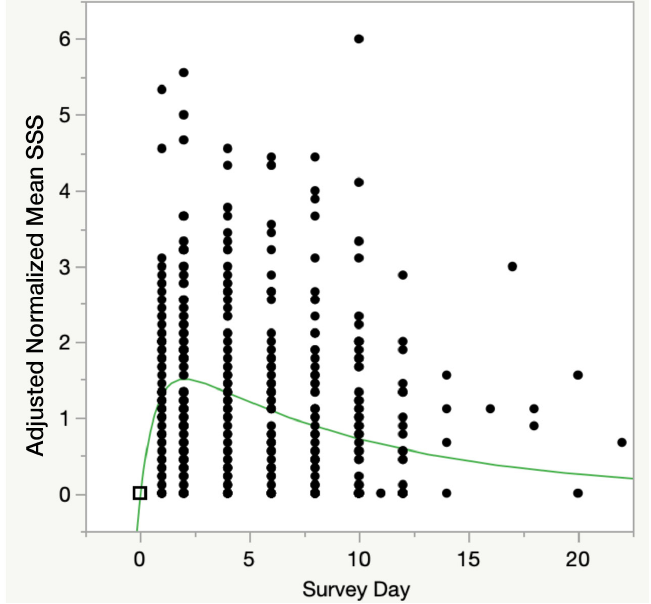
Figure 7. Oral Dose Pharmacokinetic Model of PEM Response to 2 ‐ day CPET. Oral dose pharmaco ‐ kinetic model of mean SSS score. Pre ‐ test scores were normalized to 0, and on subsequent survey days, all mean SSS scores ≤ 0 were set to 0 as representing full recovery from the 2 ‐ day CPET. F ratio = 8.41, p < 0.0005. Black box represents that in this model all subject ʹ s Mean SSS scores were normal ‐ ized (set to 0 at time 0, or pre ‐ CPET1, for all subjects); Black dots are all other normalized Mean SSS scores for each subject, at subsequent days; Green line is the mathematical solution for the model. Figure 8 shows the four ‐ parameter pharmacokinetic modeling showed a highly sig ‐ Medicina 2023 , 59 , x FOR PEER REVIEW nificant relationship for all four parameters in the model ((a): Chi 2 = 388.1, p < 0.0001; (b): Chi 2 = 32.8, p < 0.0001; (c): Chi 2 = 51.3, p < 0.0001; (d): Chi 2 = 7.91, p < 0.005). The model calculated that peak symptoms were, on average, approximately 1.5 units higher than im ‐ mediately prior to CPET1, occurred about 24 h after CPET2, and returned to the pre ‐ CPET1 value at about two weeks. Comparing Figure 7 to Figure 8, the main differences are that the Oral Dose (Figure 7) model assumes no exercise ‐ related effects prior to the CPETs (Mean SSS = 0), whereas Figure 8 shows exercise ‐ related effects prior to the CPETs (Mean SSS > 0). Both are normalized, wherein all subjects are given equal scores immedi ‐ ately prior to CPET1.